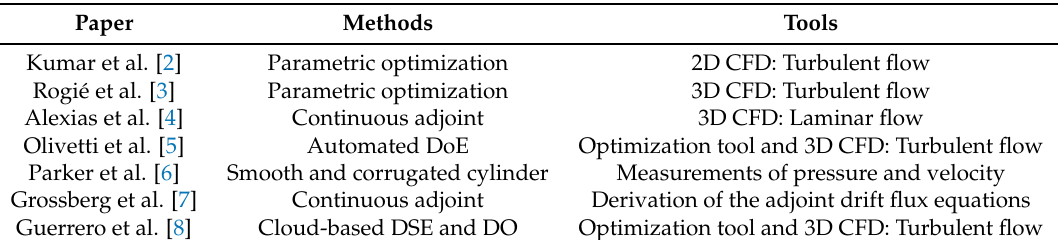
Table 2. Overview of the Special Issue research contributions: Optimization methods and tools. Abbreviations: Computational Fluid Dynamics (CFD), Design of Experiments (DoE), Design Space Exploration (DES) and Design Optimization